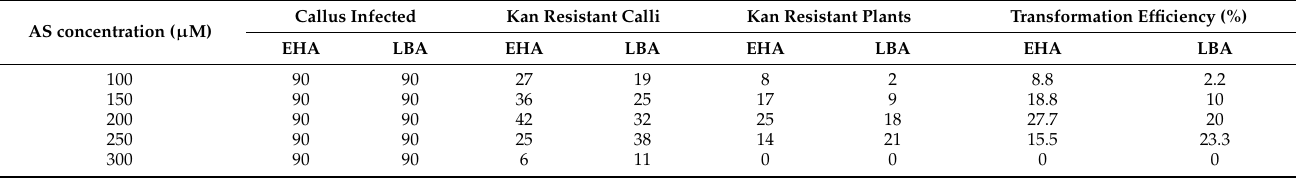
Table A4. Effect of AS concentration in infection medium on transformation efficiency of callus derived from seeds of P. scrobiculatum L.